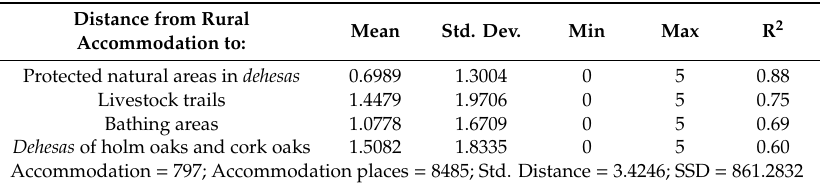
Table 6. Overall variable